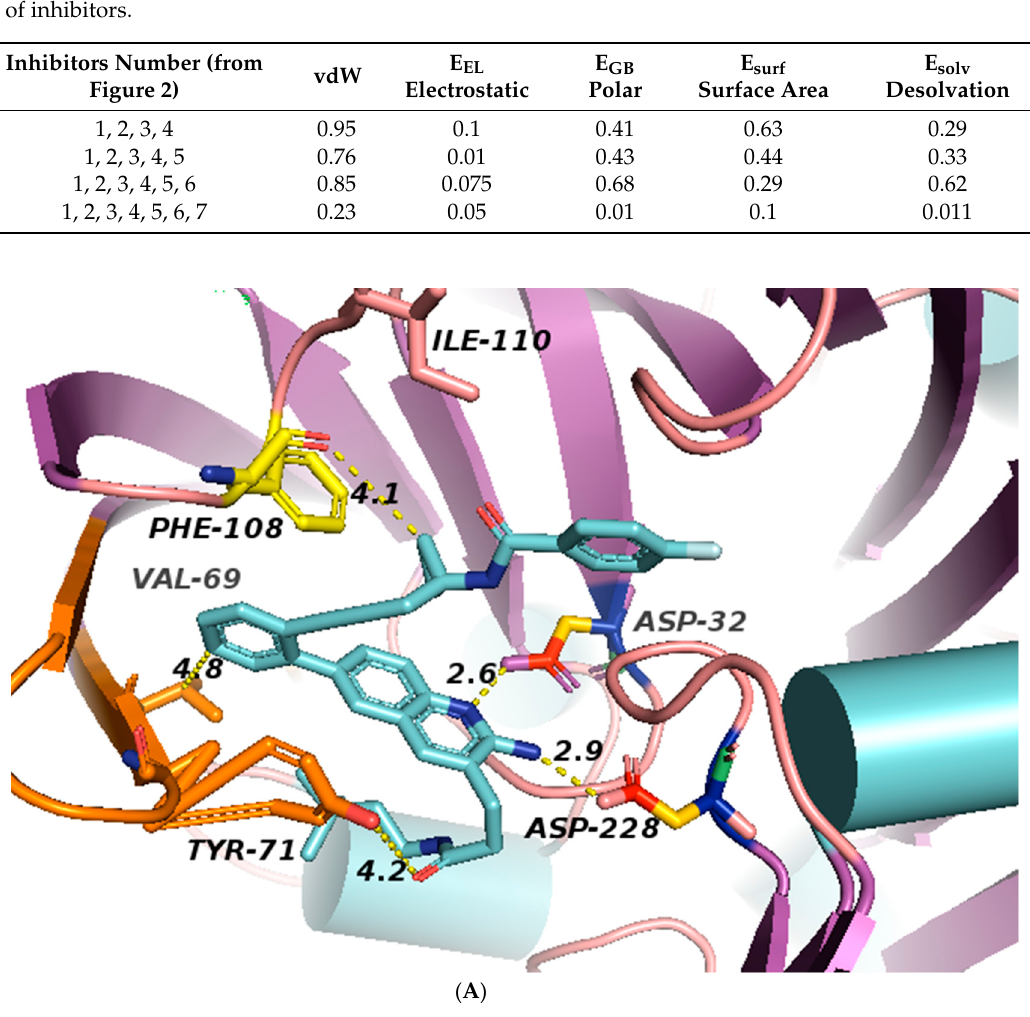
Table 4. Correlation coe ffi cients (R 2 ) of ∆ H with contributing energies (from Table 2) for groups of inhibitors.